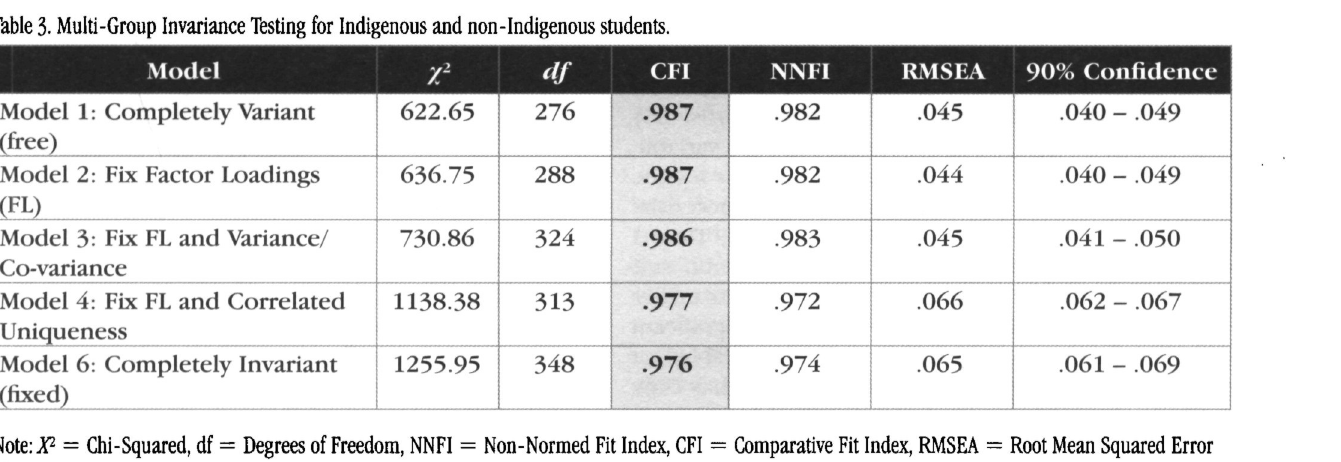
Table 4. Causal Ordering Model for the Indigenous Australian